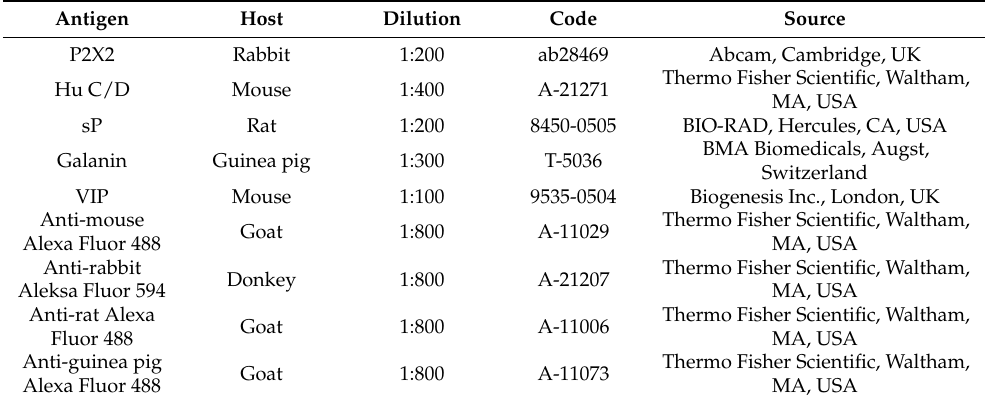
Table 1. The detailed specification of used primary and secondary